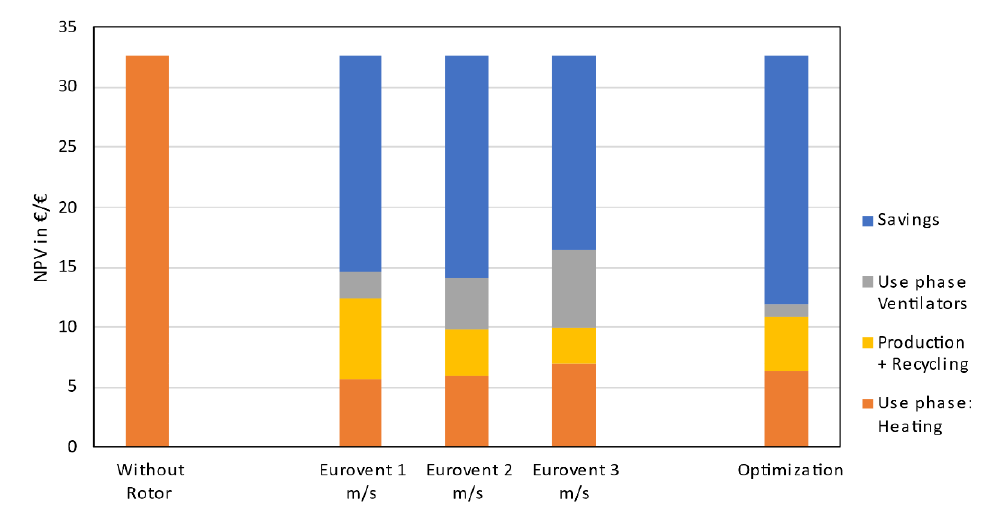
Figure 9. 25 €/t CO 2 Eq. scenario with optimized RHX and Eurovent RHX under different operating ambient air empty tube velocities at 10,000 m 3 /h.